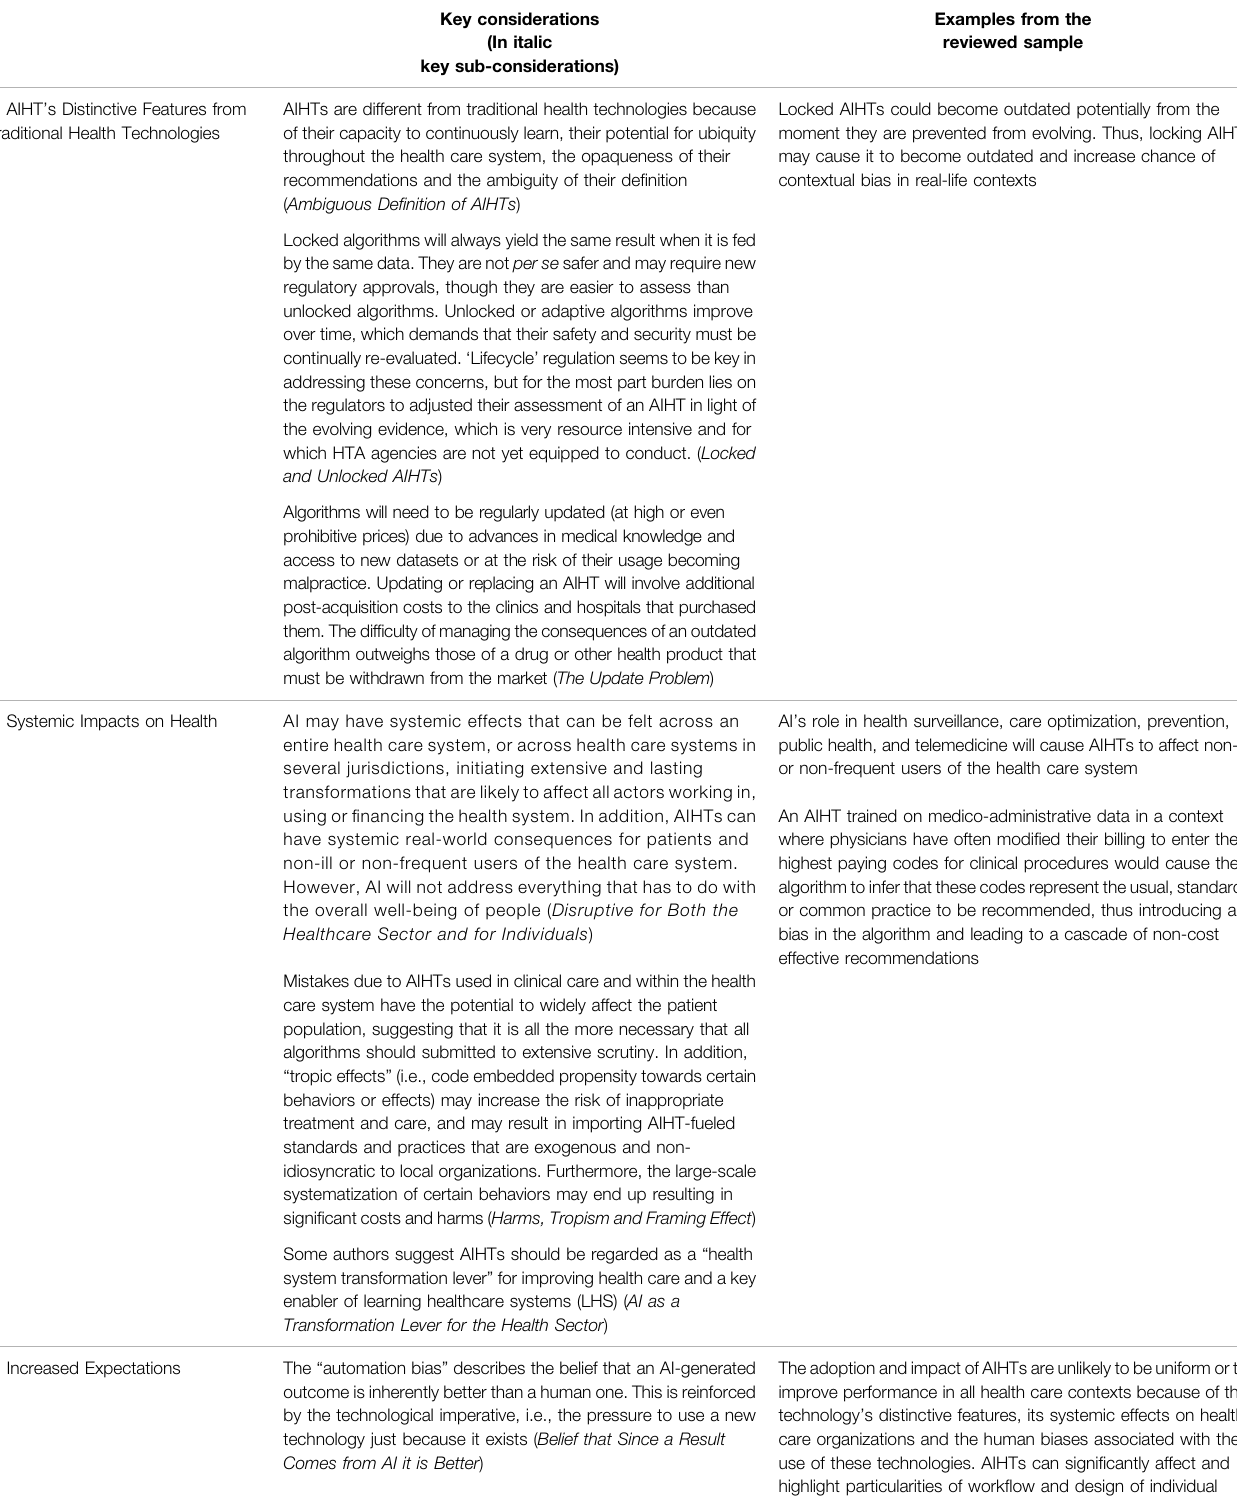
TABLE 3 | A summary of the fi ve main aspects of AIHT ’ s exceptionalism.